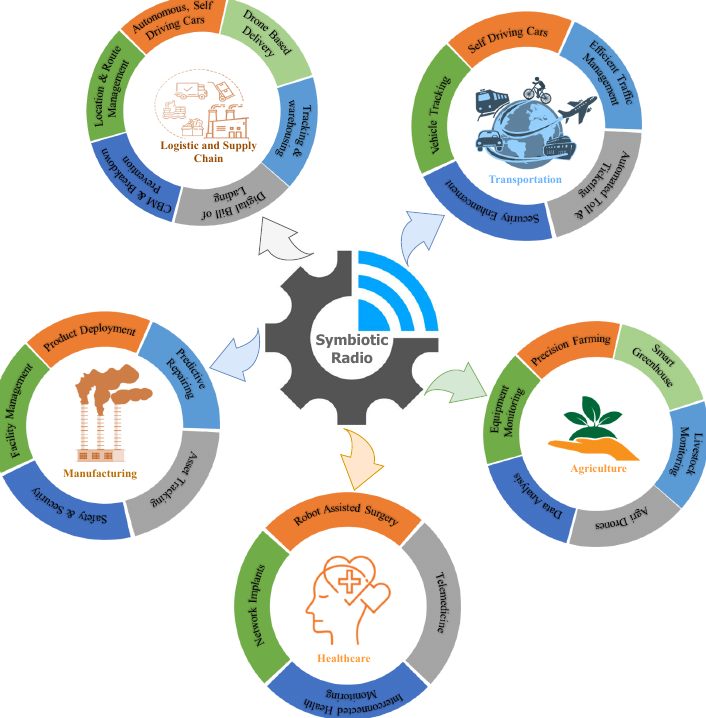
Figure 8. Applications of Symbiotic